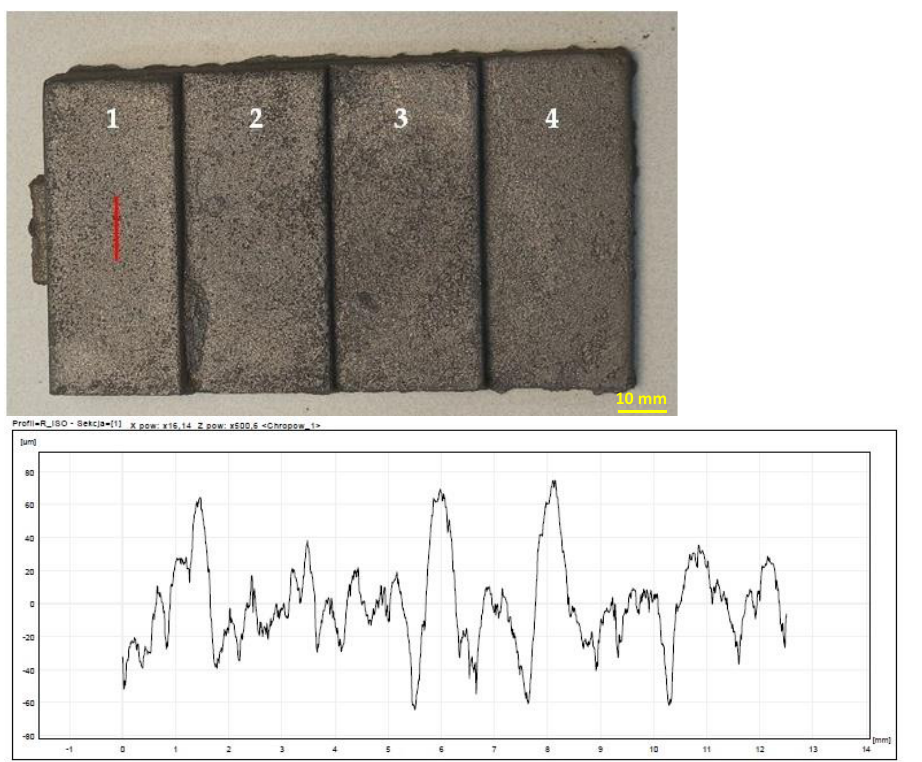
Figure 13. Raw casting made in a mold with a mass of B 8%. A chart of an example of surface roughness for the 1st “stair” of the casting. 1–4 are numbers of stairs of the casting.